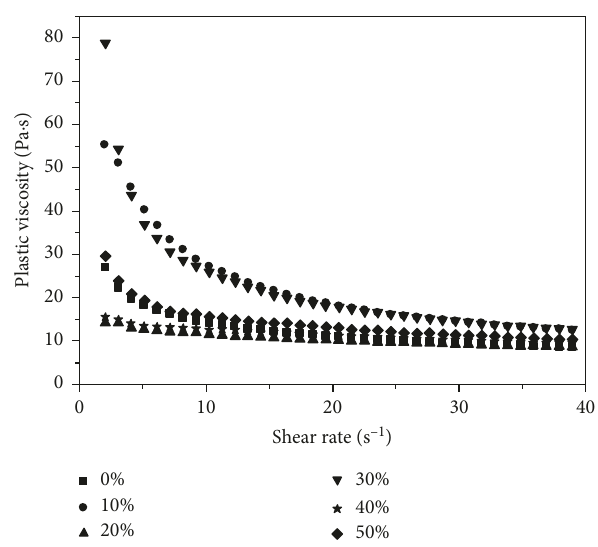
Figure 12: Influence of shear rate on plastic viscosity of mortar